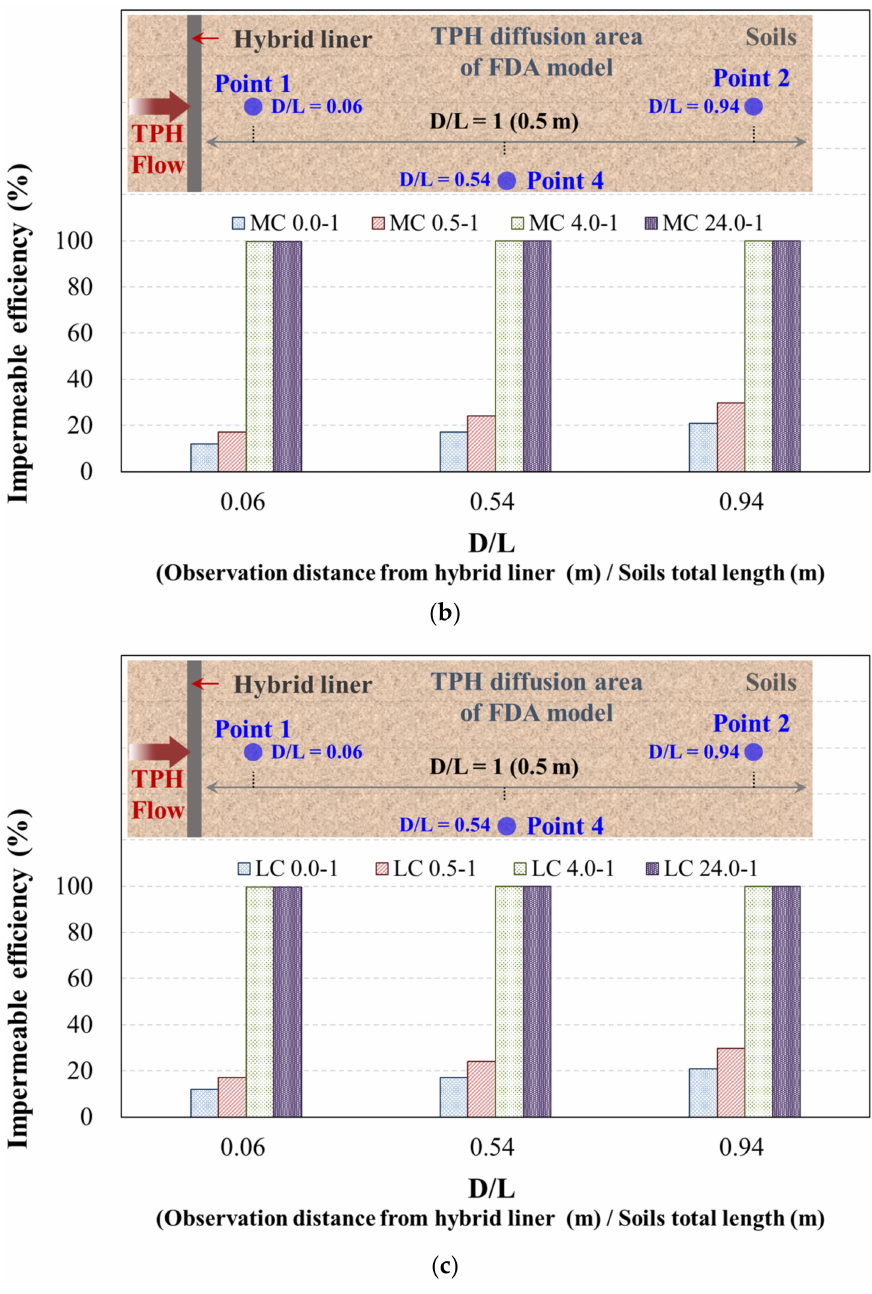
Figure 9. Evaluation of the impermeable efficiency using D/L: ( a ) High-TPH condition (6000 ppm); ( b ) Medium-TPH condition (2000 ppm); ( c ) Low-TPH condition (500 ppm). With regard to the influence of the observation point distance, as the distance ratio from the hybrid liner was increased, the concentration reduction ratio increased regardless of the hybrid liner-TPH reaction time. The following is an evaluation of the observation point distance, excluding the conditions of a hybrid liner-TPH reaction time of 4 h or more, where the concentration reduction ratio is 99 to 100%. For the high-TPH condition, in which the hybrid liner-TPH reaction time was 0 h, the concentration reduction ratios were 12.5%, 22.1%, and 17.8%, with respect to distance ratios of D/L = 0.06, 0.54, and 0.94, respectively. When the hybrid liner-TPH reaction time was 0.5 h, the concentration reduction ratios were 16.9%, 24.0%, and 29.7% with respect to distance ratios of D/L = 0.06, 0.54, and 0.94, respectively. For the medium-TPH condition, in which the hybrid liner-TPH reaction times were 0 h and 0.5 h, the concentration reduction ratios were 12.0% to 20.8% and 17.0%